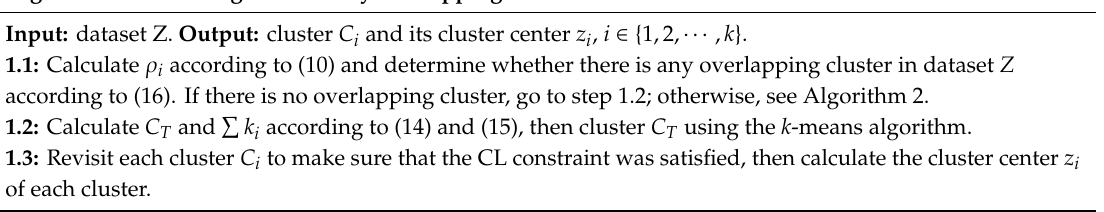
Algorithm 1 Clustering without any overlapping cluster in dataset Z